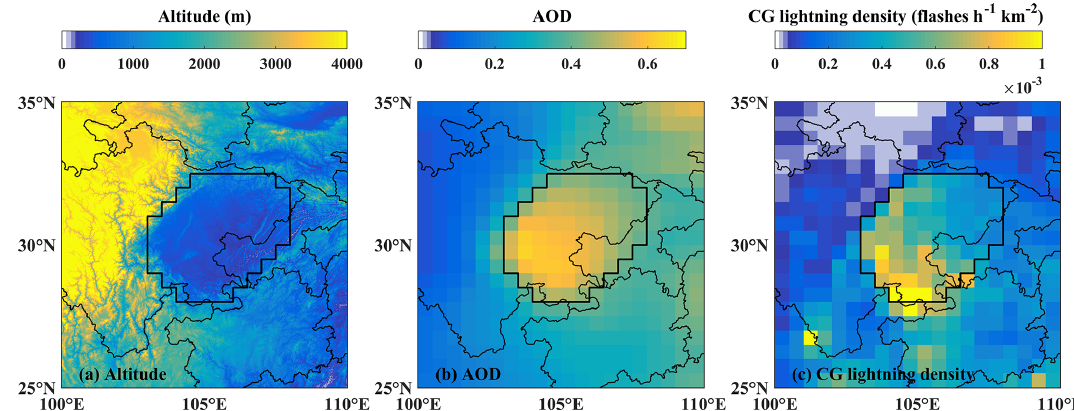
Figure 1. (a) The terrain of the study region with a spatial resolution of 0 . 02 ◦ × 0 . 02 ◦ . Spatial distributions of (b) aerosol optical depth (AOD) and (c) CG lightning density (flashes h − 1 km − 2 ) at a spatial resolution of 0 . 5 ◦ × 0 . 5 ◦ for the summer months (June, July, and August) of 2010–2018. The black lines in (a–c) outline the specific area investigated in this study.